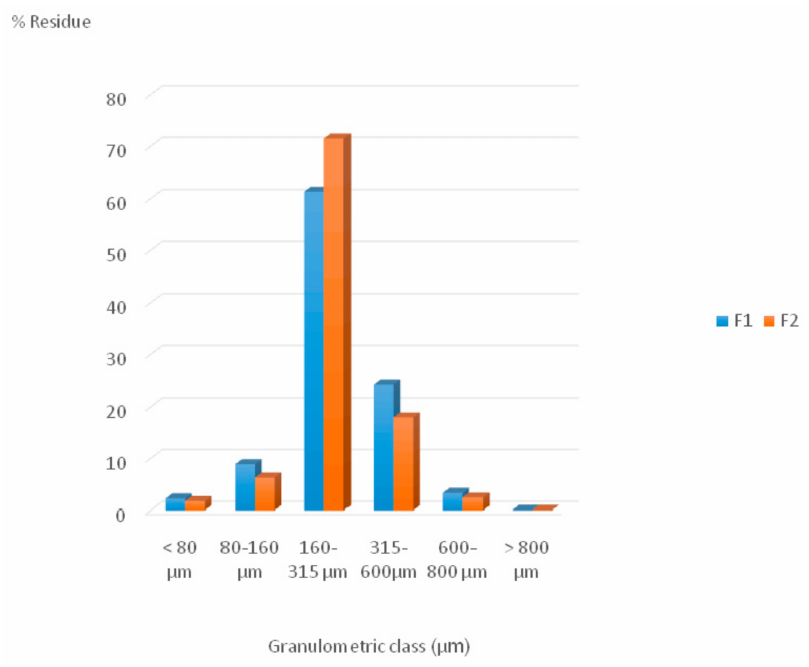
Figure 7. Granulometric analysis of the material for direct